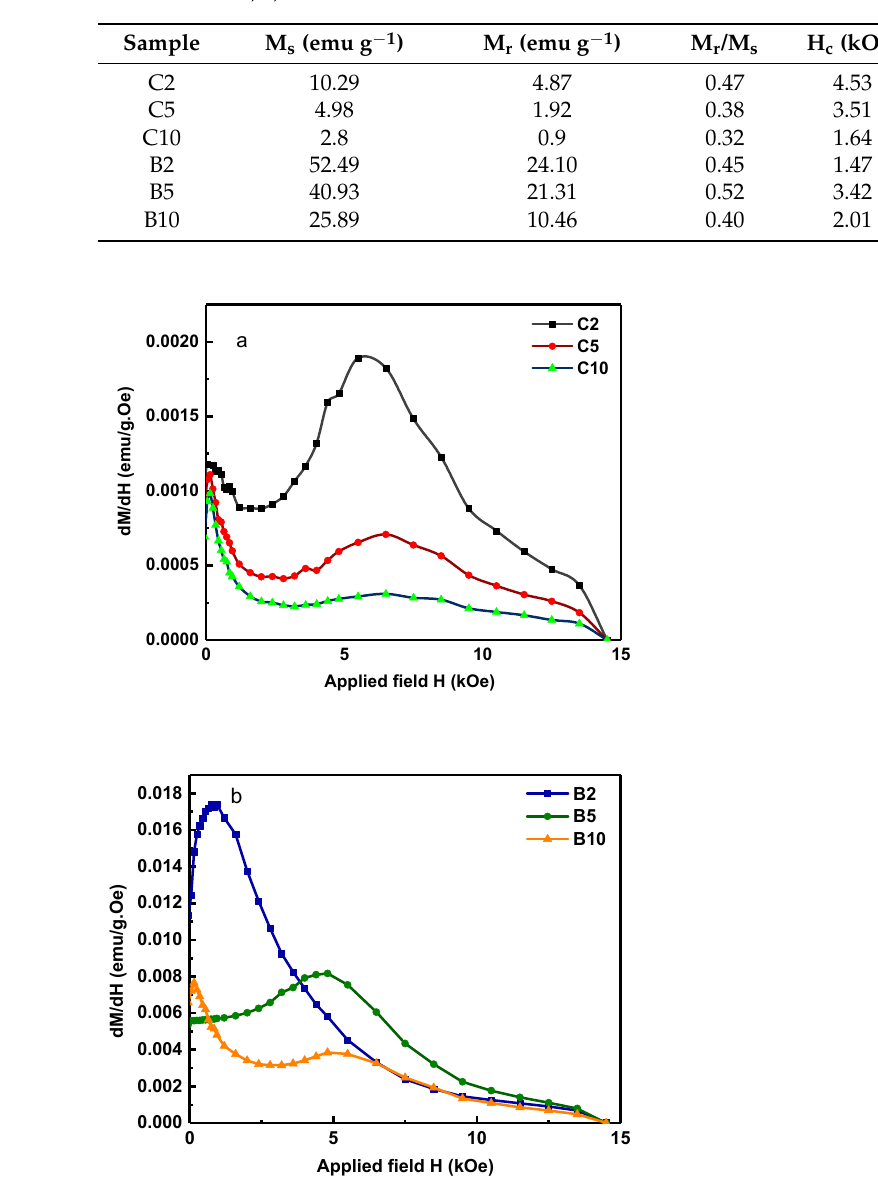
Table 3. Magnetic properties for the Mn 52 Al 45 . 7 C 2 . 3 samples after milling in cylindrical and barrel containers for 2, 5, and 10 h.